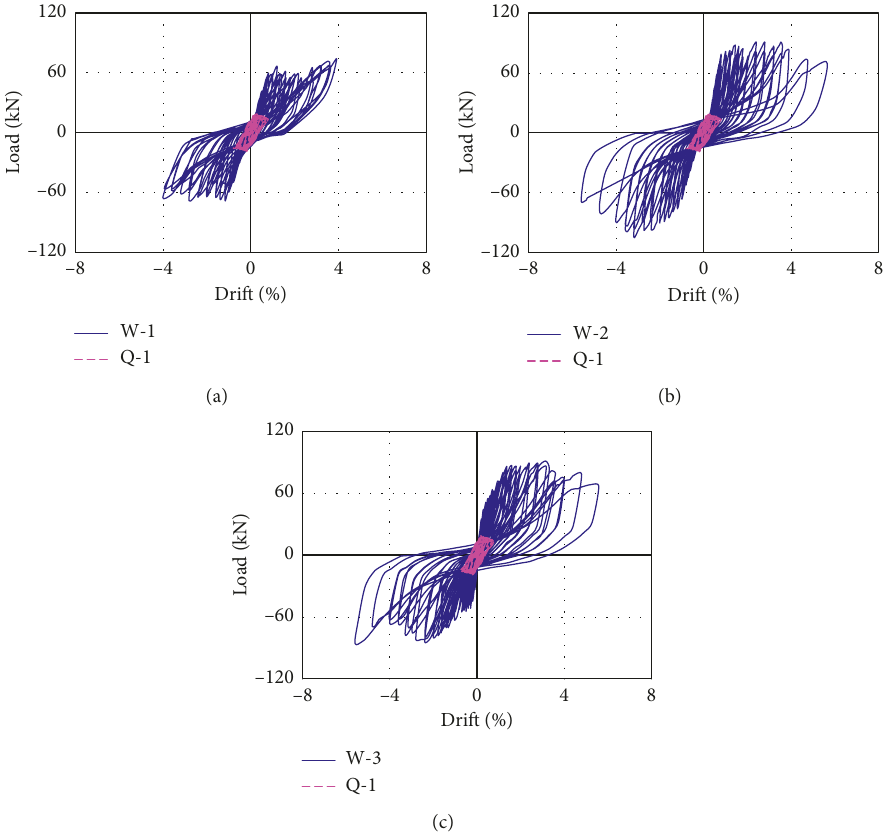
Figure 9: Hysteresis curves for the tested specimens. (a) Specimens W-1 and Q-1. (b) Specimens W-2 and Q-1. (c) Specimens W-3 and